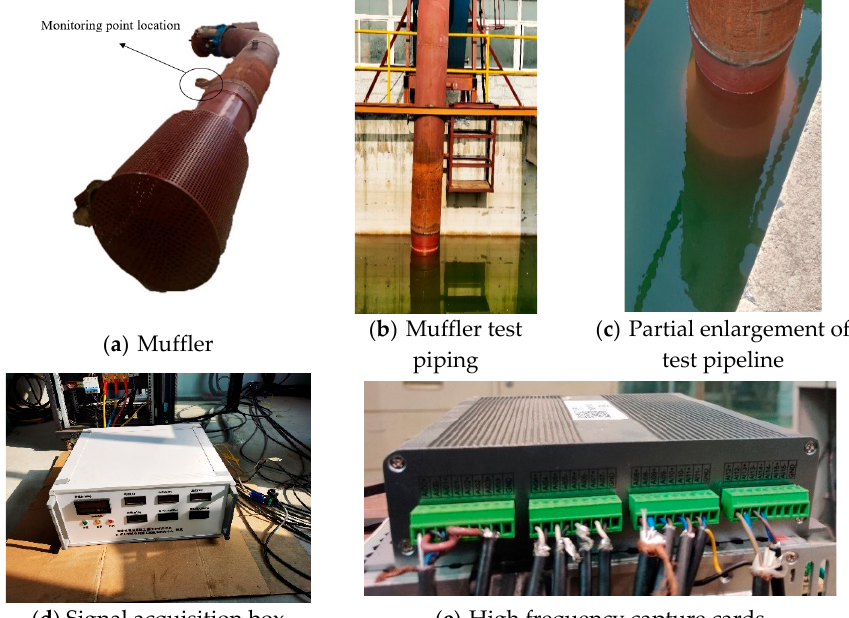
Figure 6. Muffler piping test equipment.